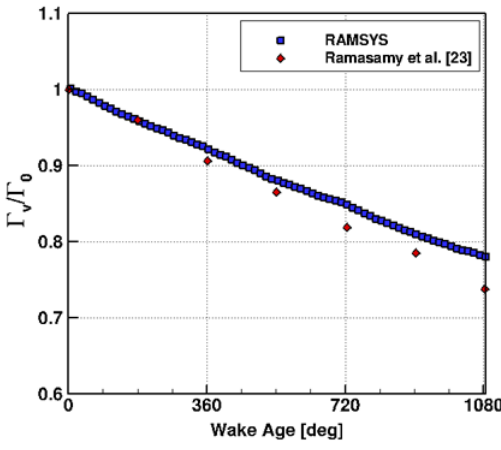
Figure 6. Normalized vortex circulation vs. wake age.